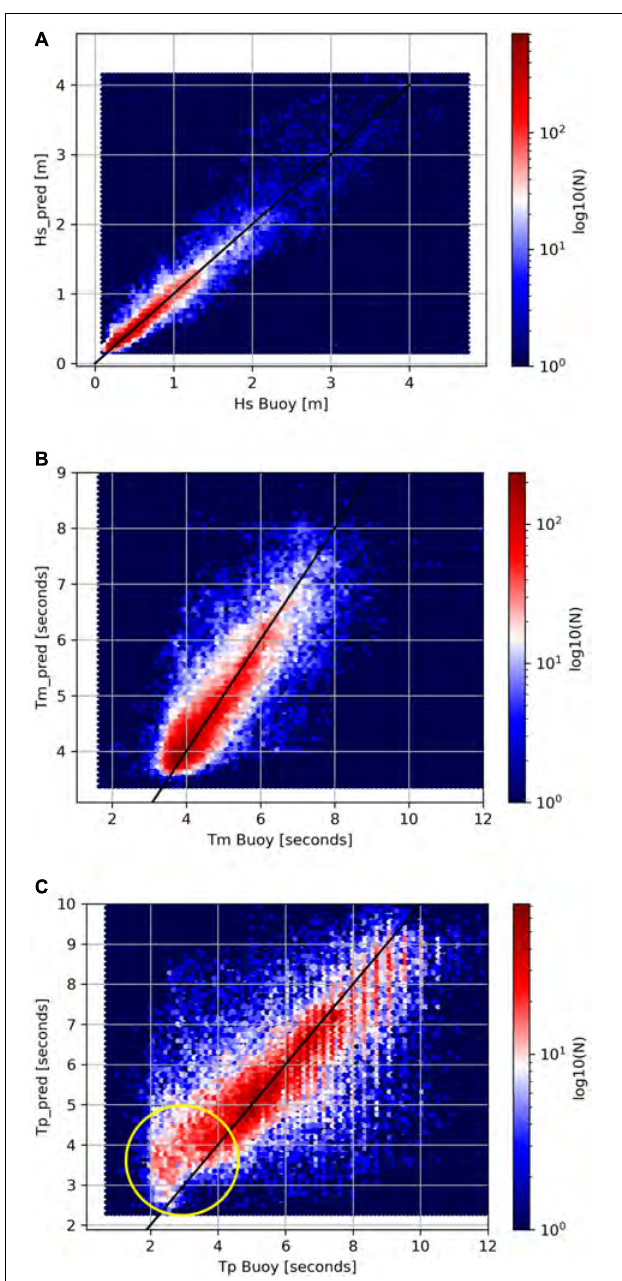
FIGURE 13 | Hexagonal binning plots of the H s (A) , T m (B) , and T p (C) values predicted by a Random Forest (20 predictors) model vs. those measured by the buoy. Validation data from